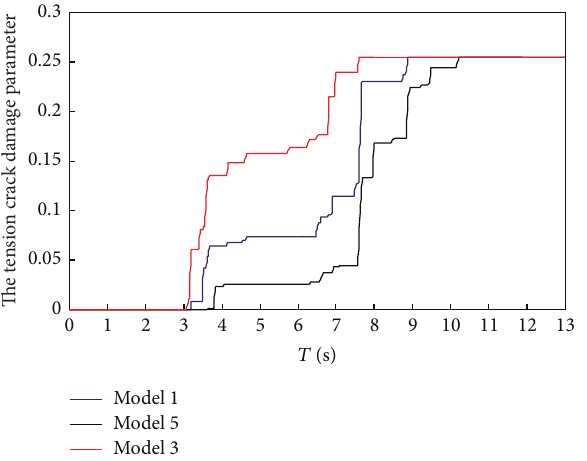
Figure 40: The parameter ratio of pier between windows and spandrel under Wolong ground